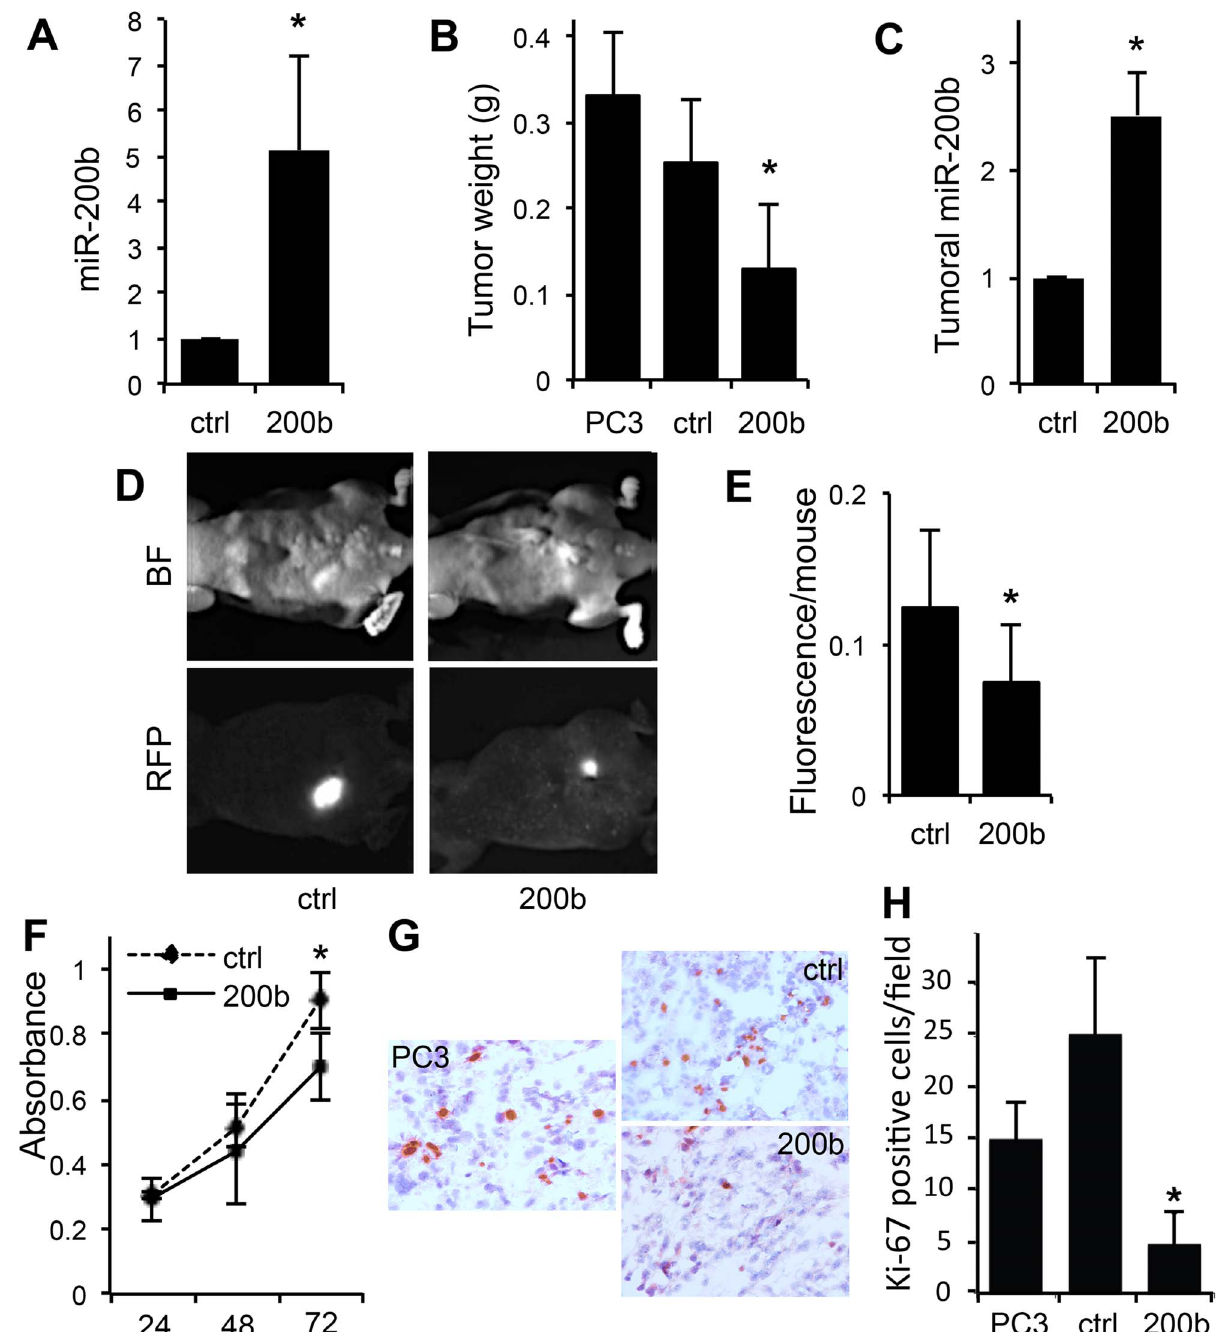
Figure 3. miR-200b is sufficient to decrease tumor growth. A) Forced expression of miR-200b in PC3 cells. PC3 cells were trasduced with a bicistronic lentiviral shuttle vector (pMIRNA1 pCDH-CMV-MCS-EF1-copRFP) encoding hsa-miR-200b and empty vector control (ctrl). Total RNA was isolated and miR- 200b expression measured using real-time RT-PCR. The values represent three independent experiments performed in triplicate. *, p # 0.01. (B) miR-200b reduced tumorigenesis by PC-3 cells. Parental PC3 cells, PC3 cells trasduced with miR control (ctrl) and miR-200b were subcutaneously injected into the rear hindquarters of athymic male mice (n=5). Tumor weight at day 29 post-injection is shown. *, p # 0.05; **, p # 0.01. (C) The tumors maintained miR-200b expression. Relative miR-200b expression was measured by real-time RT-PCR in the tumors from panel (B). * p # 0.05. (D). miR 200b decreased tumor growth in an orthotopic model of prostate cancer. RFP-tagged PC3-ctrl and PC3-200b cells were implaned in the prostates of athymic male mice. The average fluorescence was measured 20 days post injection. (E) Fluorescence per animal was determined using whole body imaging, with Olympus OV100 system. *, p # 0.05. (F) Cell growth was measured by WST-1 assay. PC3-ctrl or PC3 miR- 200b cells were seeded at 3000 cells per well in a 96-well plate. Absorbance was measured at indicated time points using a Biorad Model 680 microplate reader. The results represent the average of three independent experiments performed in triplicate. *, p # 0.05 by Student’s T-test. (G, H) Tumor sections were stained for Ki-67, to evaluate proliferation. Note a significant decrease in Ki-67–positive nuclei in the presence of miR-200b. *, p , 0.001.